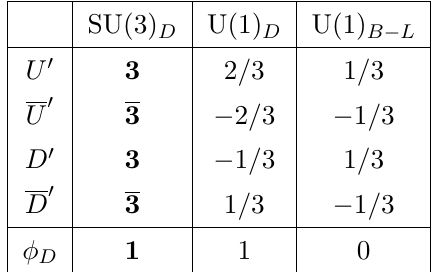
Table 1 . Charge assignment of the dark quarks and the dark Higgs for a composite ADM model. SU(3) and U(1) are gauge symmetries of the dark sector, while U(1) D D shared with the visible